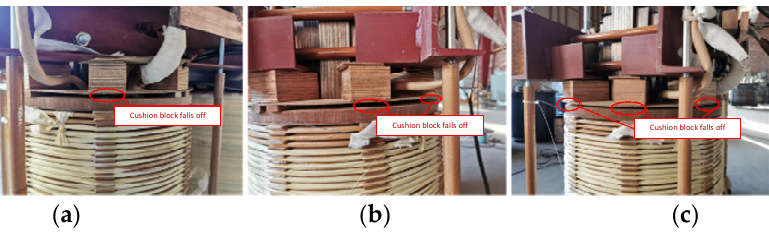
Figure 11. Site layout of pad falling in different loosening ranges. ( a ) 90°. ( b ) 135°. ( c ) 180°. Table 3. Test scheme for winding end pad falling and combined winding loosening. Group